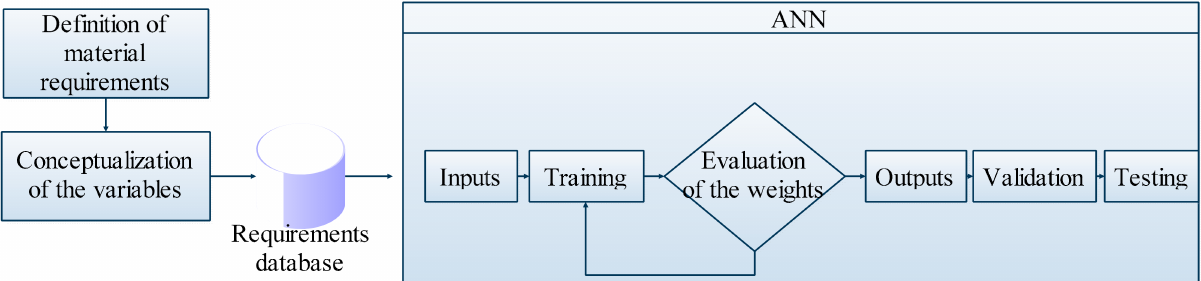
Figure 3. Diagram of the methodology for selecting the geomembrane. For the sake of clarity, each of the stages are described in the following